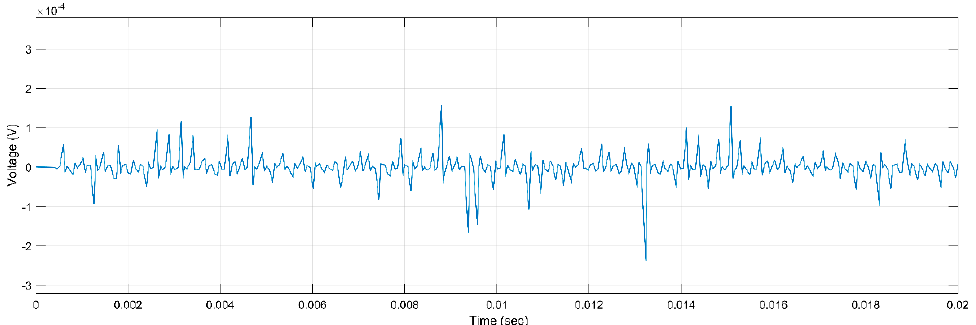
Figure 9. PD Activity for Combination, 5 kV, h, r.